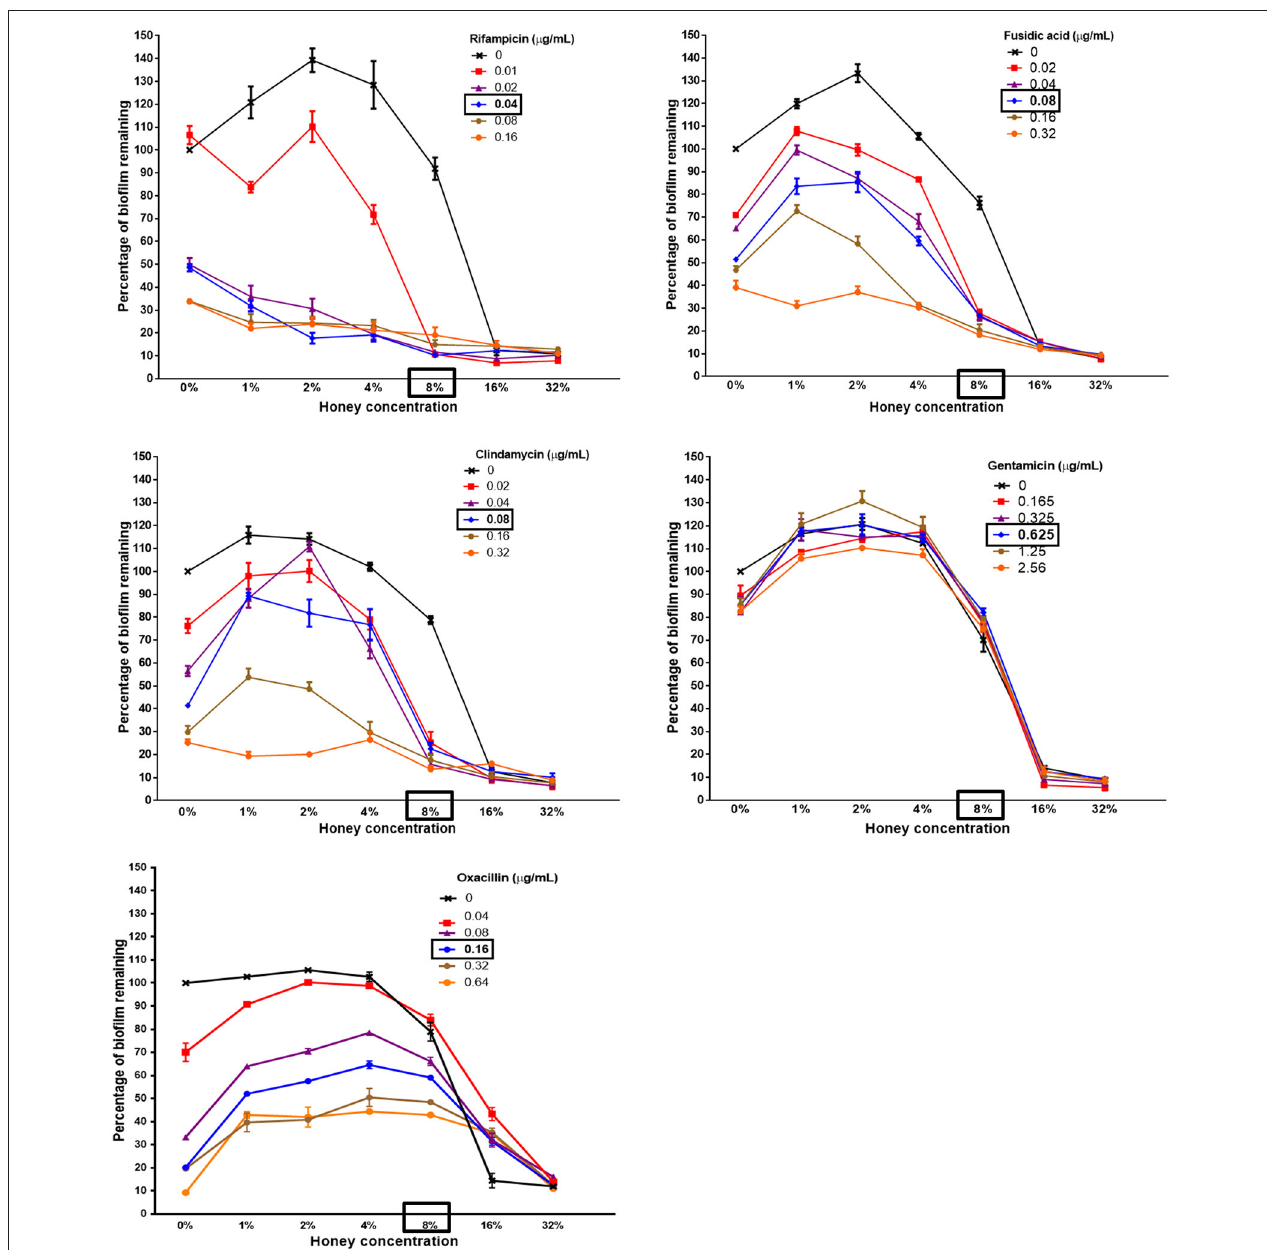
FIGURE 2 | The ability of Medihoney-antibiotic combinations to remove biofilm varies greatly with different antibiotics Medihoney-rifampicin combinatorial treatment showed the greatest reduction in biofilm even when the antibiotic was used at sub-inhibitory levels. Medihoney combined with either fusidic acid or clindamycin also reduced biofilm substantially. Combinations of Medihoney with gentamicin or oxacillin did not reduce biofilm any more than that which was achieved by the antibiotic alone. Error bars represent the standard error of the mean (SEM) of triplicate samples performed in duplicate. The MIC of each antibacterial agent is shown in bold and